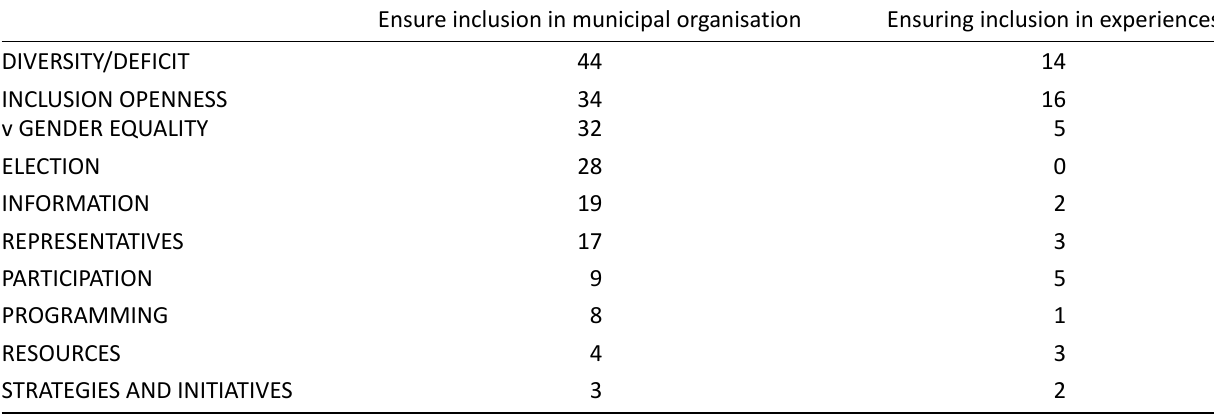
Table 2. Table of